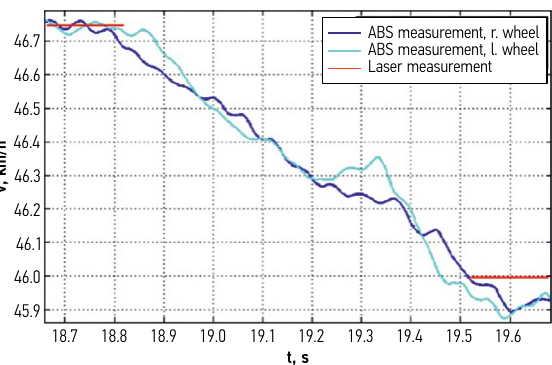
Fig. 11. Experimental ABS sensor data, car velocity on gravelled road covered with snow